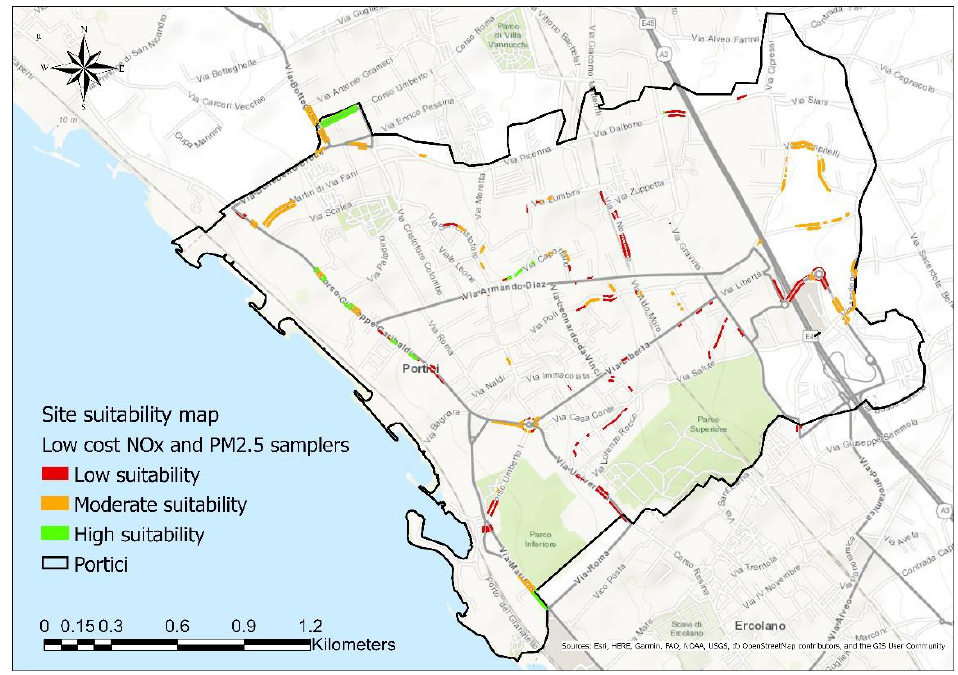
Figure 9. Site suitability map for networks of low-cost traffic-orientated stations for air pollutants monitoring across the city of Portici.